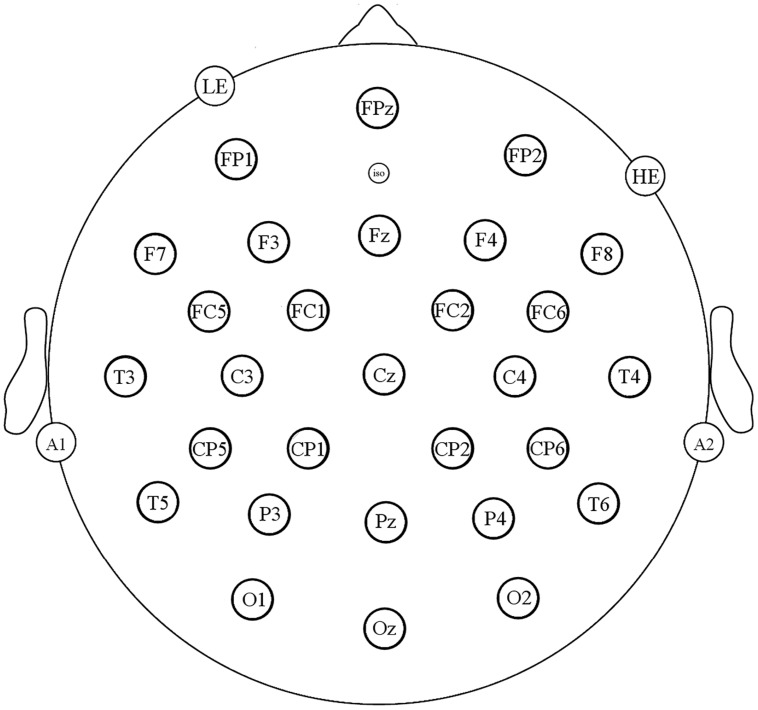
Recording montage.